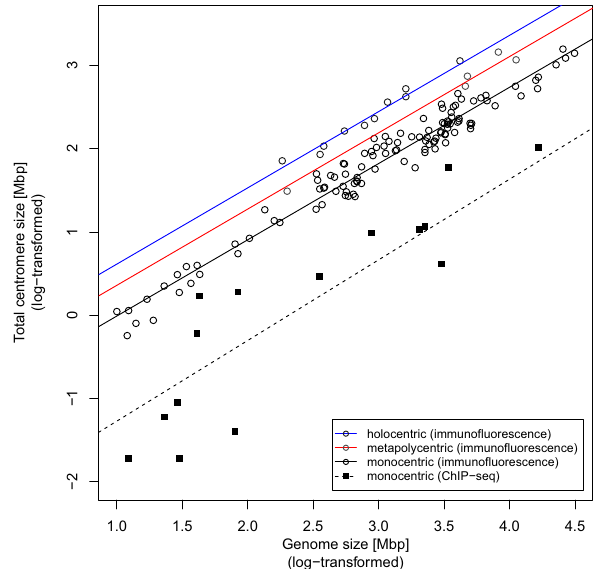
Figure 2. Relationship between the genome size (log-transformed) and the total centromere size (log- transformed) and the effects of chromosome type on this relationship as estimated by the phylogenetically corrected regression model (see details in Table 1). The figure was generated using basic plot functions in R v4.0.2 35 .